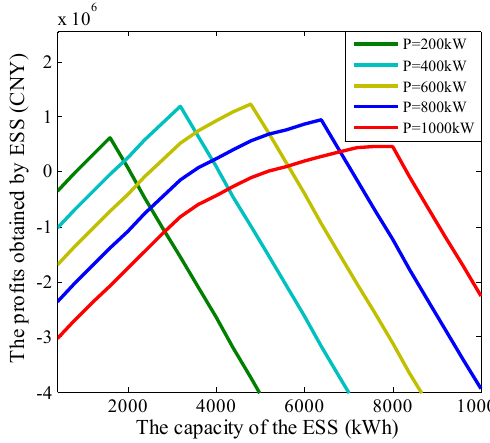
Figure 9. The profit curves of different rate powers of ESS.